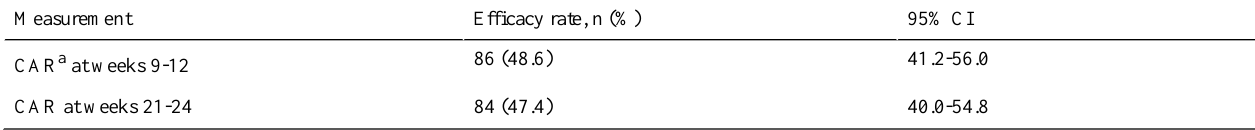
Table 2. Efficacy of the ascure